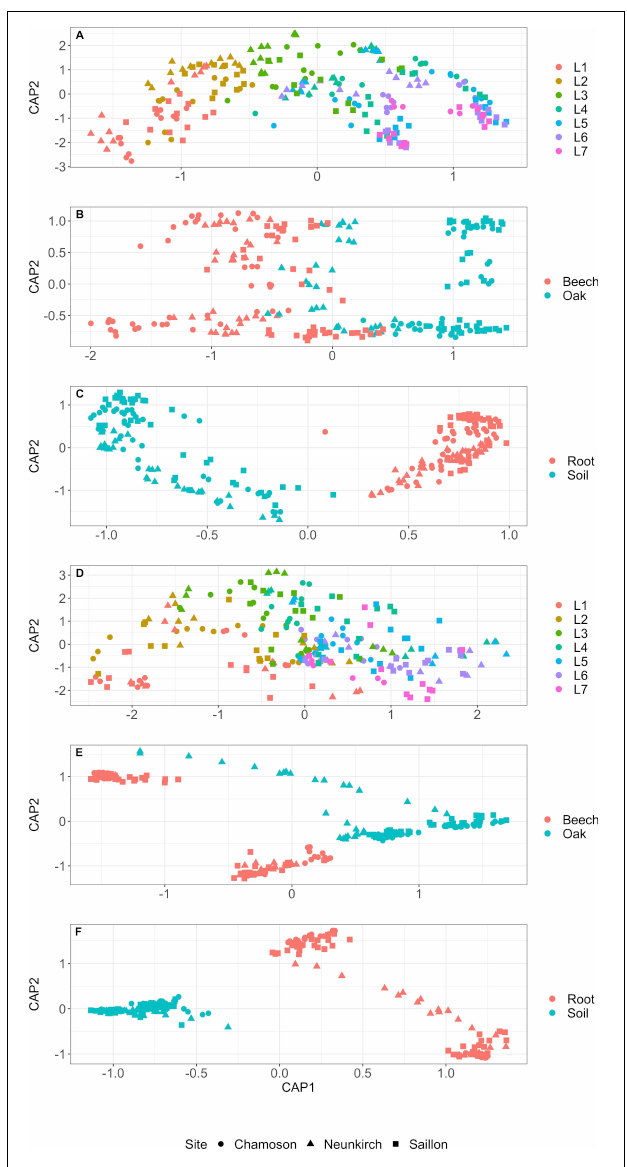
FIGURE 2 | Canonical analysis of principal coordinates (CAP) based on Bray–Curtis dissimilarities for bacterial and fungal communities. (A) Bacterial communities in the various soil layers (L1–L7) of three forest locations. (B) Bacterial communities in the beech and oak sites of the three forest locations. (C) Bacterial communities in the soil and fine root substrates of the three forest locations. (D) Fungal communities in the various soil layers (L1–L7) of three forest locations. (E) Fungal communities in the beech and oak sites of the three forest locations. (F) Fungal communities in the soil and fine root substrates of the three forest